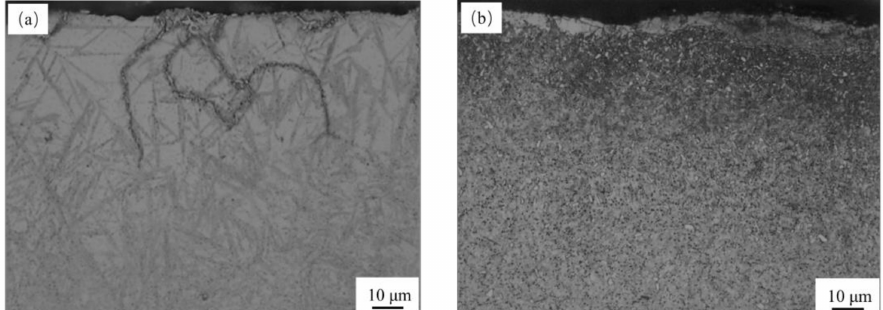
Figure 5. Surface organization of carburized layer of 16Cr3NiWMoVNbE steel under ( a ) the average carbon flux model and ( b ) the segmented average carbon flux model after carburizing and